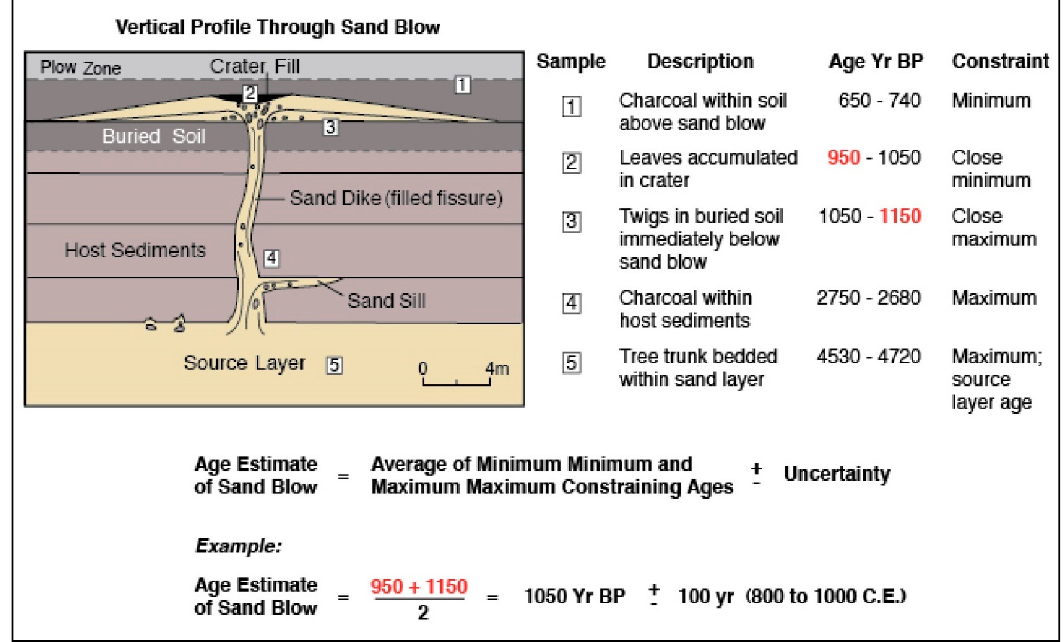
Figure 16. Diagram illustrating sampling strategies and age estimation of liquefaction features (modified after References [35,116]).